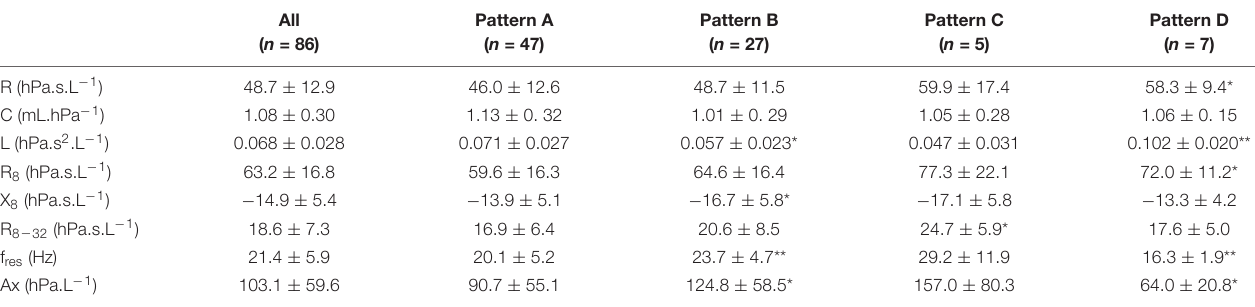
Mean ± SD values. For definitions of Patterns A-D, see text or the legend to Table 1 . R, resistance (model fitting); C, compliance (model fitting); L, inertance (model fitting);